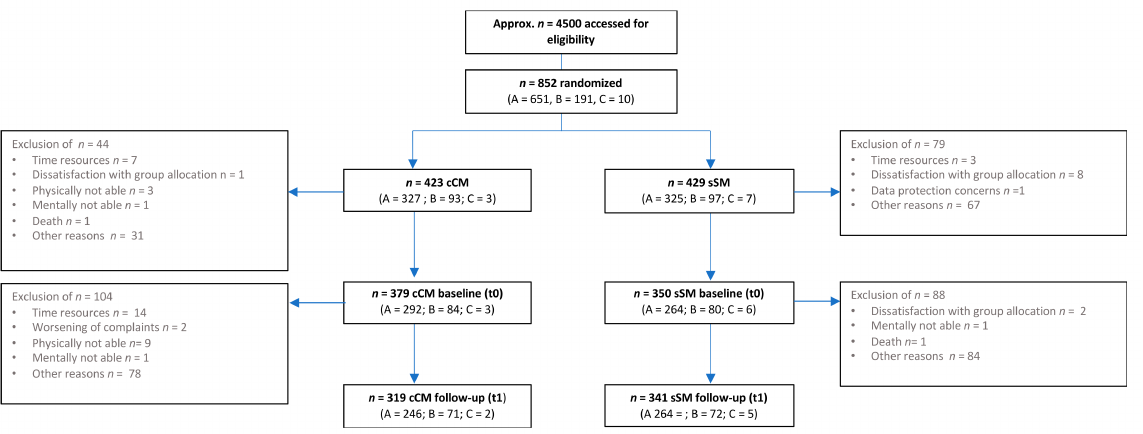
Figure 2. Study flow chart.